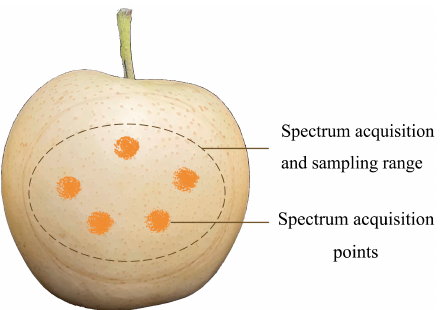
Figure 2. Schematic diagram showing the acquisition points for spectral sampling.